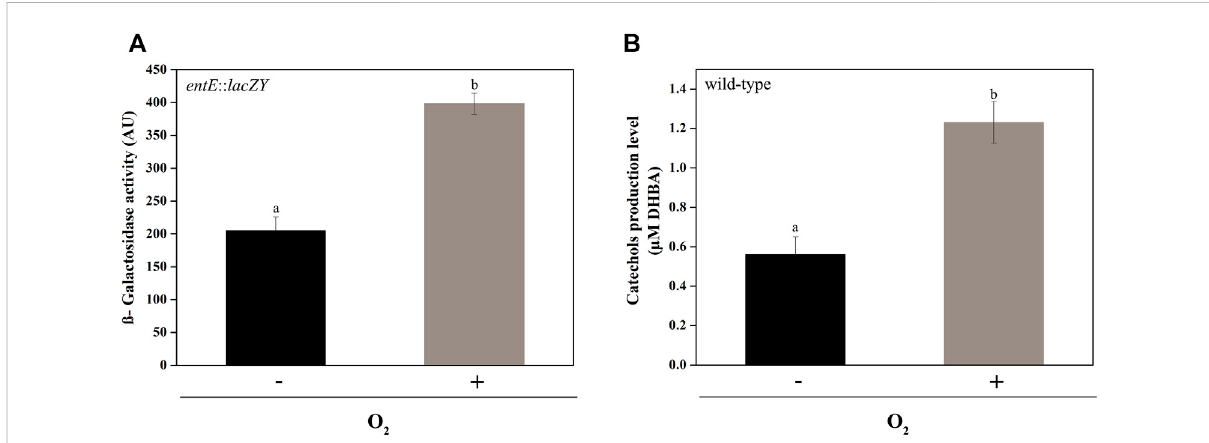
FIGURE 4 Comparison of entE expression and catechol production in aerobic and anaerobic culture conditions. (A) entE expression in aerobic and anaerobic culture conditions determined by means of β − Galactosidase assay using a strain with an entE::lacZY chromosomal fusion. (B) Determination of catechol production level in supernatants of E. coli wild-type in aerobic culture conditions compared with anaerobic ones. Quantitation was done using Arnow assay with fi lter-sterilized supernatants. Results are expressed as μ M equivalents by comparison to a